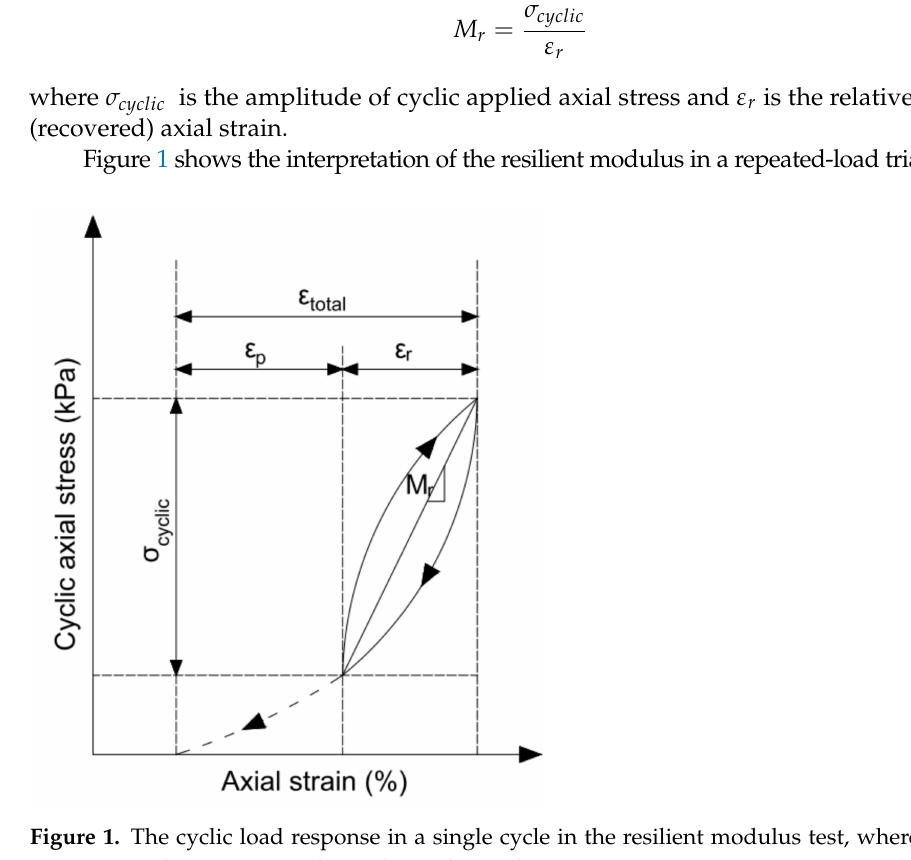
Figure 1. The cyclic load response in a single cycle in the resilient modulus test, where ε p is the permanent relative strain and ε r is the resilient relative